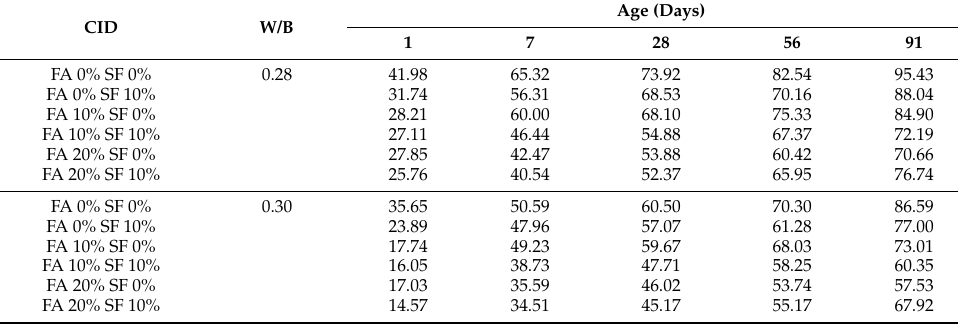
Table A1. Source data for tests on compressive strength (unit: